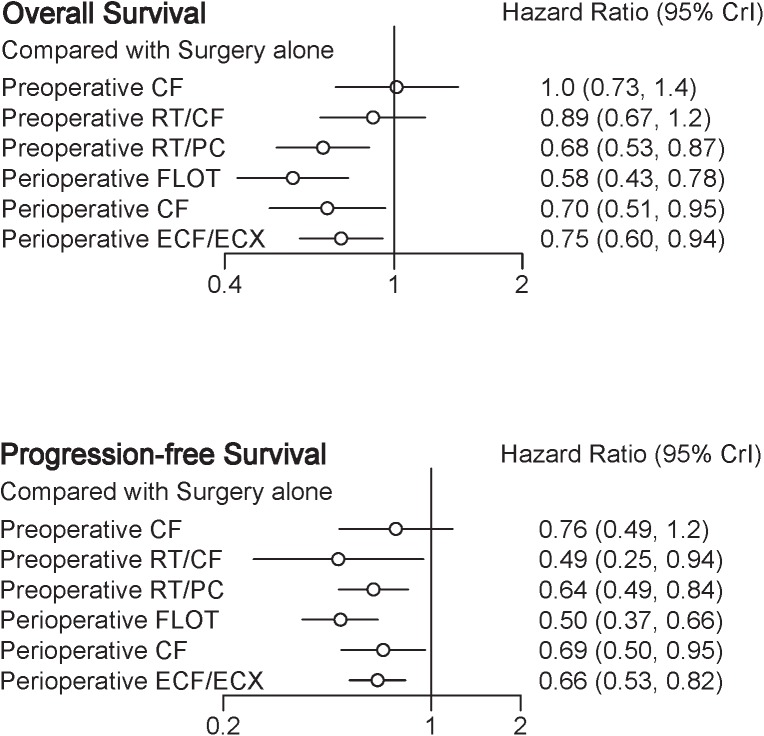
Forest plots of results with surgery alone as the common reference.